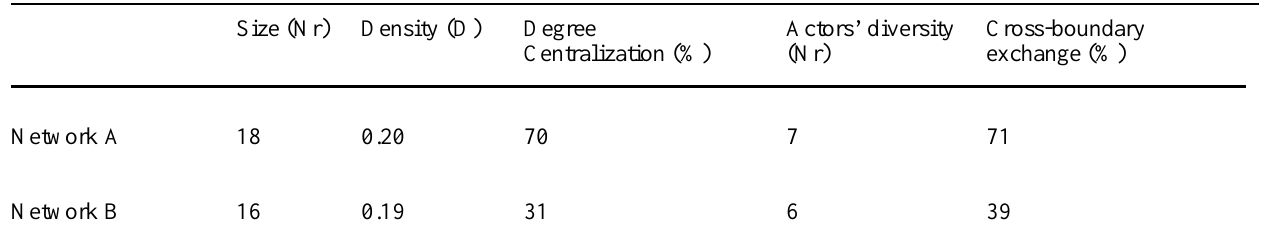
Table 2. Rule-making